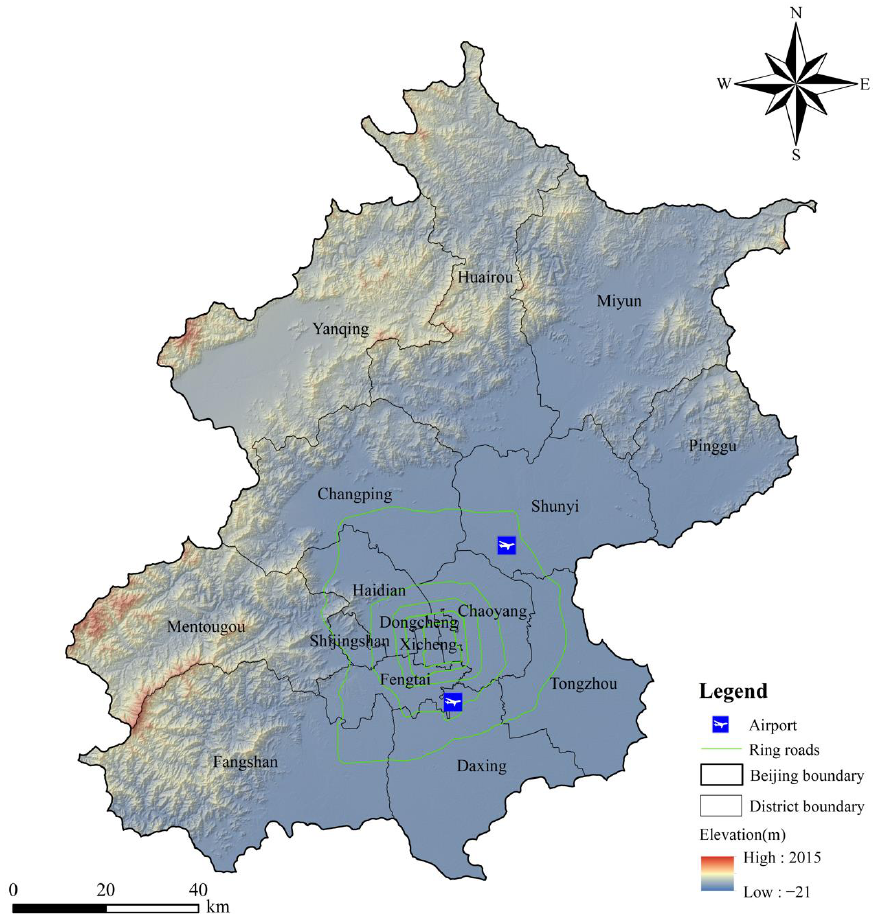
Figure 1. The Beijing study area.